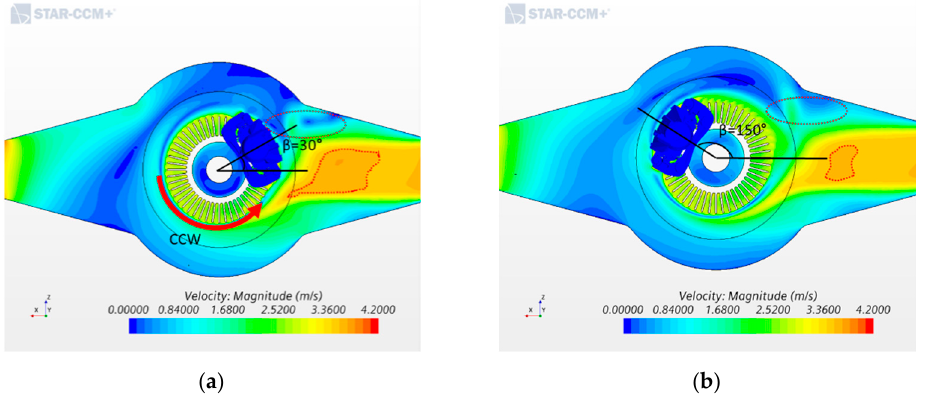
Figure 10. Flow velocity magnitude for caliper angles: ( a ) β = 30° ;( b ) β = 150°.